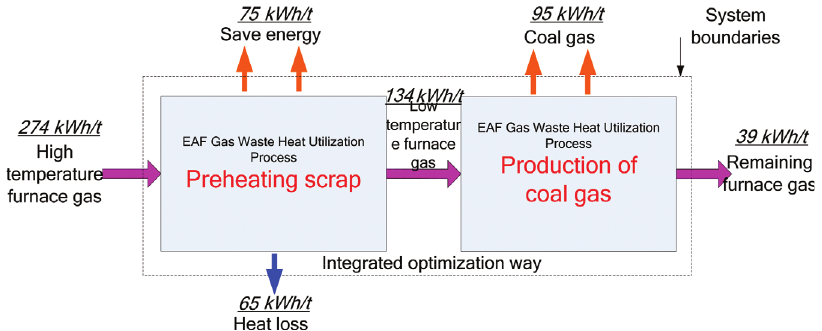
Figure 6: System boundaries of the integration scheme of EAF gas waste heat utilization.